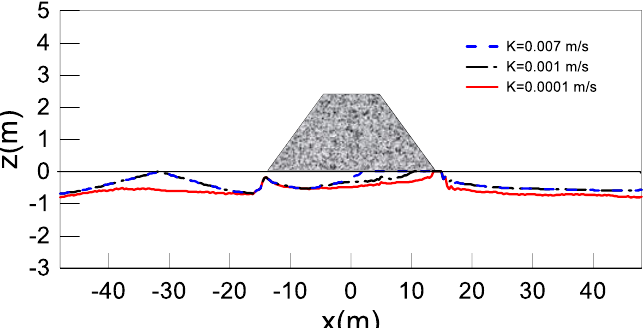
Figure 13. Development of liquefaction potential around the breakwater with varied soil permeability. The distribution of the wave-induced pore pressure s in the breakwater and marine sediments with respect to different soil permeability ( K ) is presented in Figure 14. Com- pared with the magnitude of the pore pressure at locations B, C, and D, that at location A has no significant difference for cases with various soil permeability. This is resulted from point A locating inside the breakwater not in the soil region. Due to point C embedded below the structure, the magnitude of the wave-induced pore pressure at C is relatively small compared to that at points B and D. It can be found that the wave-driven pore water pressure in soil increases with increasing soil permeability.